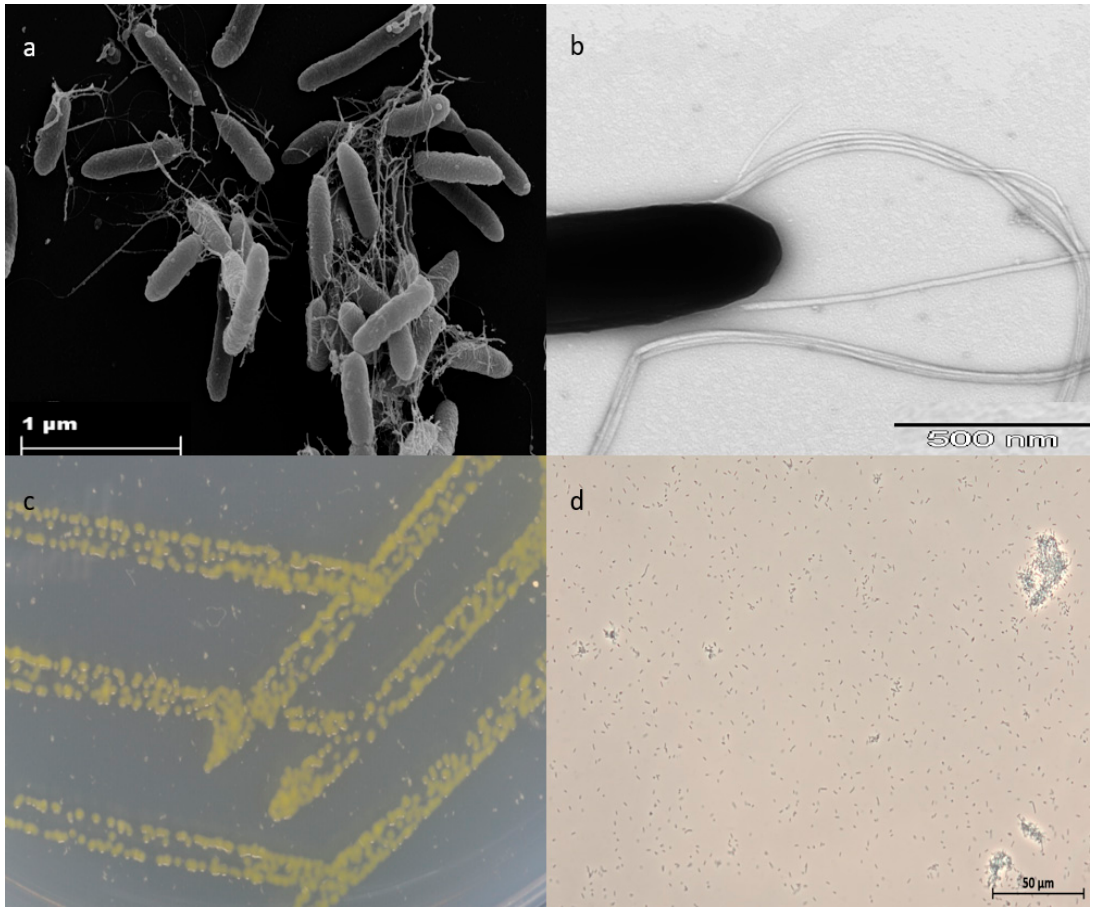
Figure 1. ( a ) Scanning electron micrograph (SEM) of cells grown on marine agar with the formation of cell-connecting fibers, ( b ) TEM of a single cell with cell-connecting fibers, ( c ) growth of strain NZ-96 T on marine agar after 72 h, ( d ) phase contrast microscopy of strain NZ-96 T showing rod-shaped morphology.